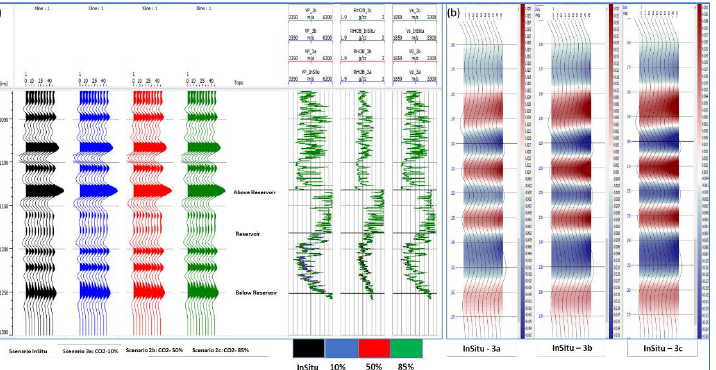
Figure 3. ( a ) Water injection well with different CO 2 saturation scenarios: angle synthetic gathers with corresponding log tracks ( b ) Water injection well: angle stack of differences between in-situ and different CO 2 saturations.